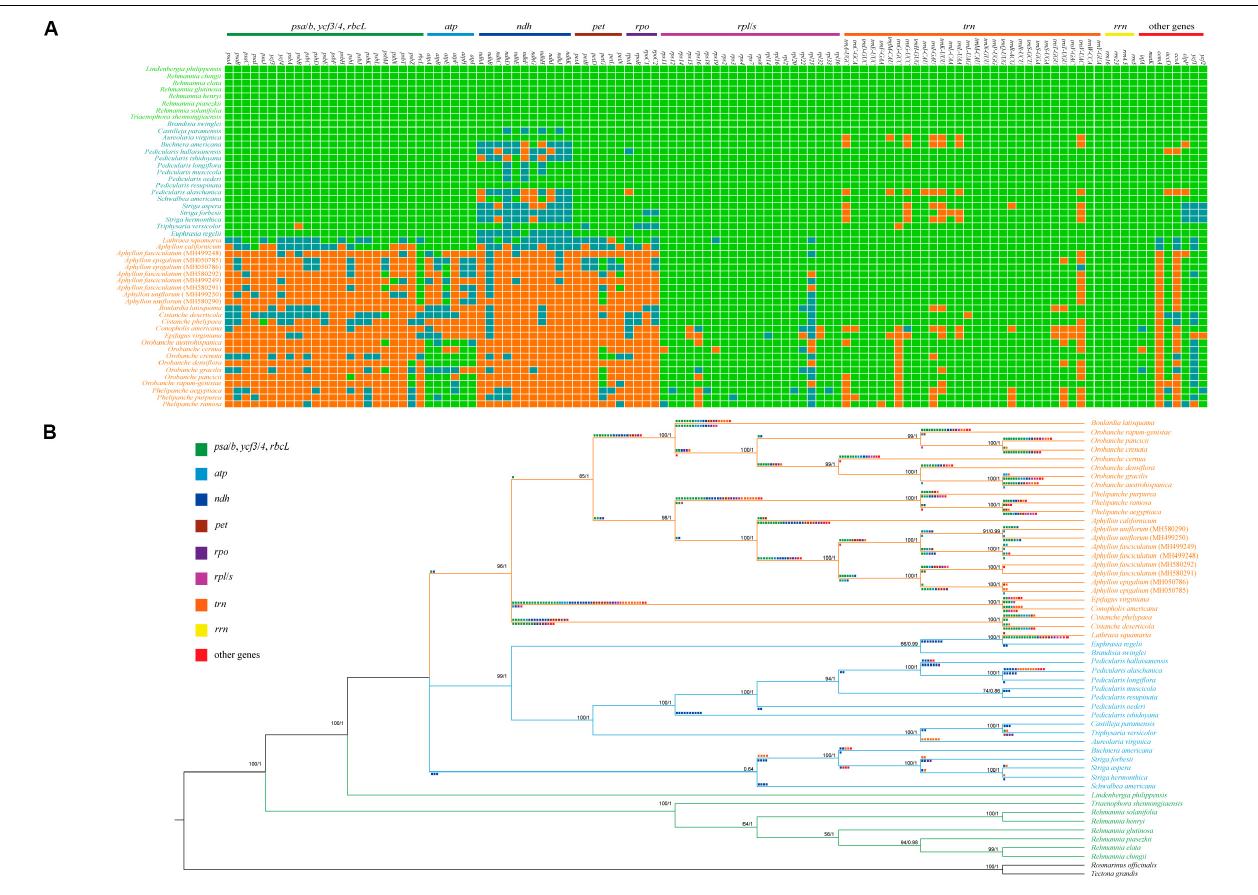
FIGURE 2 | Relationships between gene contents and phylogenetic tree of Orobanchaceae plastomes. (A) Heat map of the presence or absence of chloroplast genes in autotrophs (species names in green), hemiparasites (species names in blue), and holoparasites (species names in orange). Green blocks, presence of a gene; blue, presence of a pseudogene; orange, absence of the gene from the chloroplast genome. (B) Inferred gene losses in the phylogenetic tree of Orobanchaceae reconstructed using ML and BI methods. Pseudogenization is illustrated below the branches, whereas gene deletion is shown above the